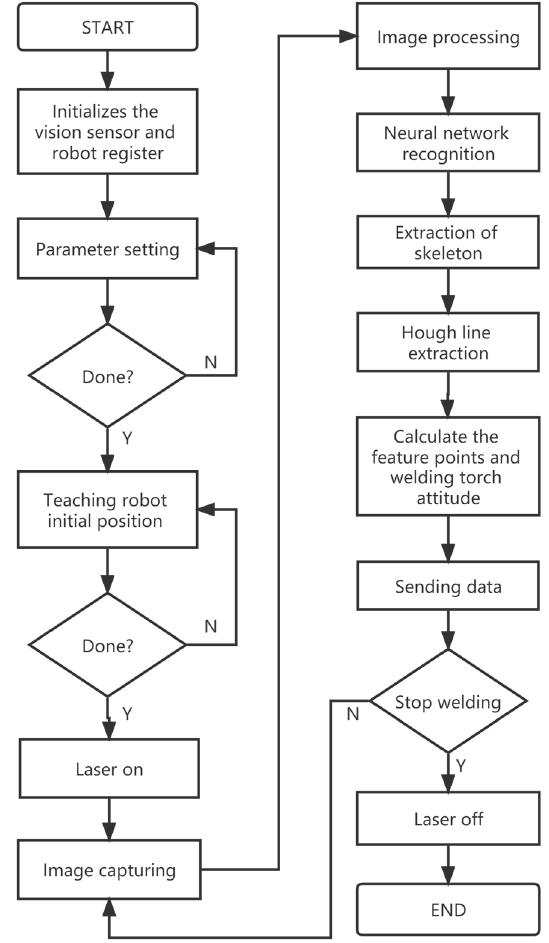
Figure 2. The weld positioning system.